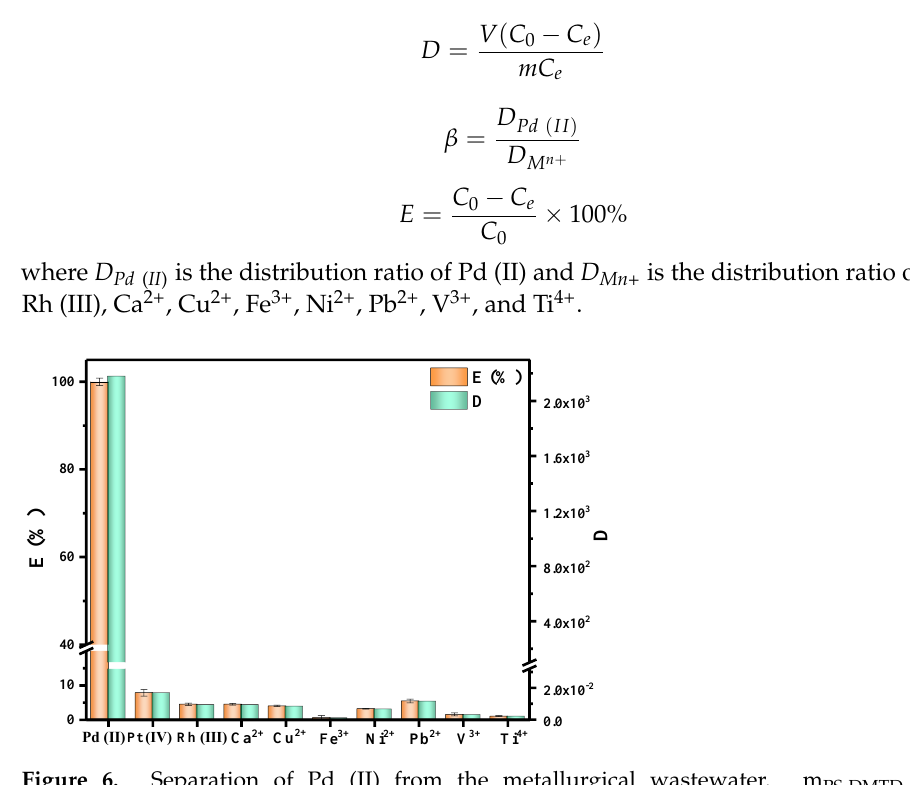
m PS-DMTD = 0.1 g,